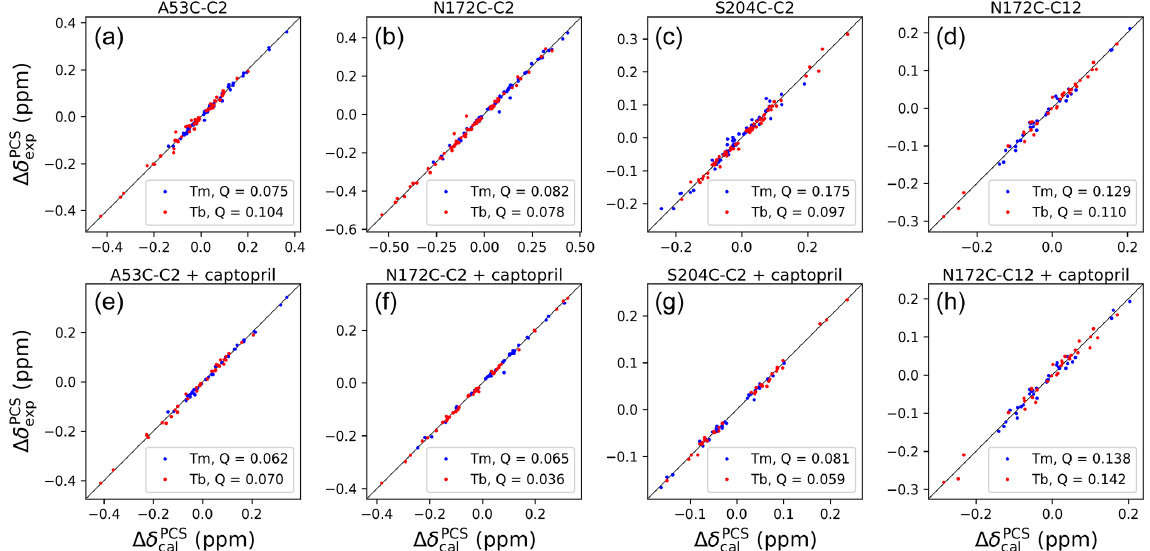
Figure 4. Correlations between back-calculated and experimental 1 H PCSs measured of backbone amides of IMP-1 with C2 tags at three different sites (positions 53, 172 and 204) and the C12 tag in position 172. Red and blue data points correspond to the PCS data obtained with Tb 3 + and Tm 3 + tags, respectively. (a) Mutant A53C with C2 tag. (b) Mutant N172C with C2 tag. (c) Mutant S204C with C2 tag. (d) Mutant N172C with C12 tag. (e) Same as (a) but in the presence of captopril. (f) Same as (b) but in the presence of captopril. (g) Same as (c) but in the presence of captopril. (h) Same as (d) but in the presence of captopril. PCS data in (a) – (d) were used to fit (cid:49)χ tensors to the structure 5EV6. PCS data in (e) – (f) were used to fit (cid:49)χ tensors to the structure 4C1F.